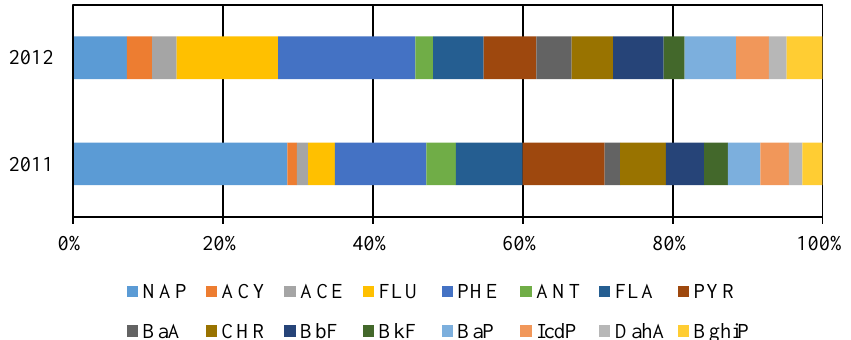
Figure 2. The compositions of PAHs from the PRE in 2011 and 2012.